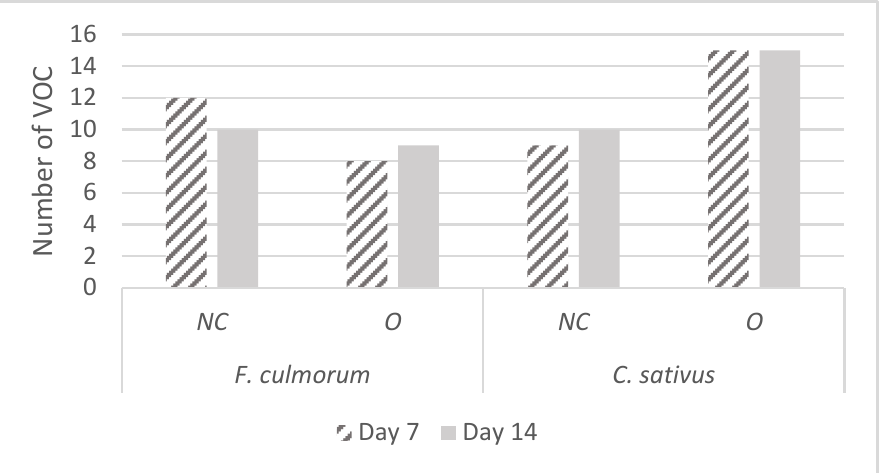
Figure 4. Number of VOCs emitted by F. culmorum and C. sativus after 7 and 14 days of culture in conditions of normal (NC) and overpopulation (O)